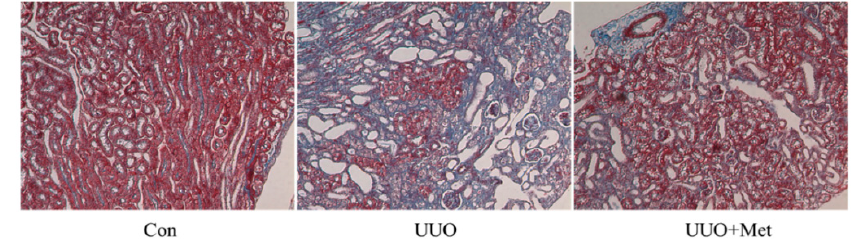
Figure 3. The effect of metformin on collagen production in unilateral ureteral obstruction mice. Representative sections of Masson’s trichrome-stained kidneys. Collagen was stained blue. Original magnifications, 200×.